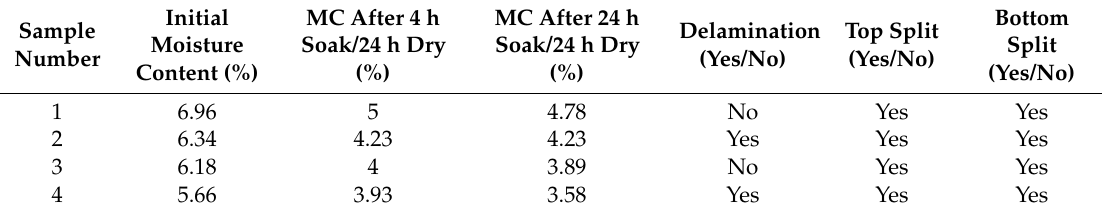
Table 4. Moisture Durability